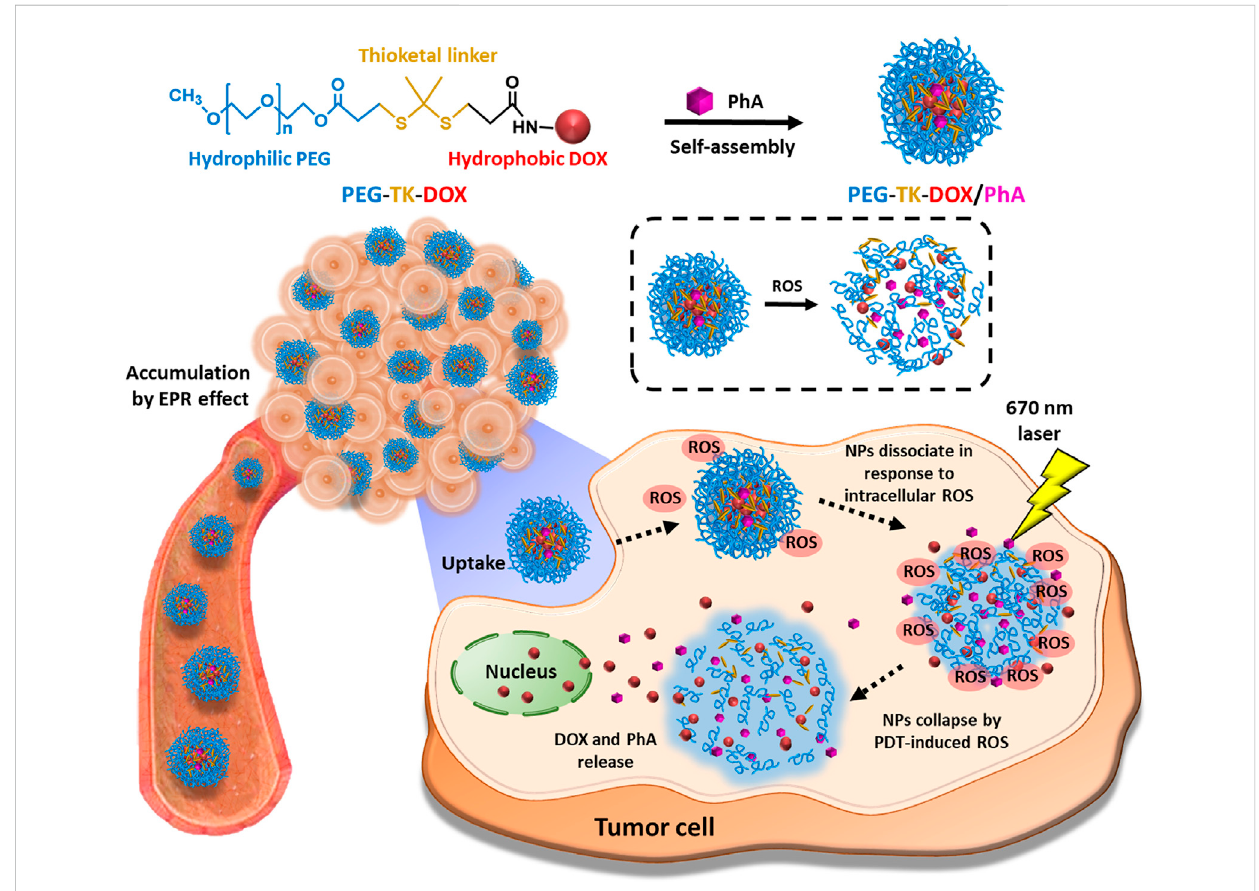
FIGURE 5 Schematic diagram of the mechanism underlying the action of PEG-TK-DOX/PhA (Kim et al., 2020). Copyright © 2020, Elsevier.